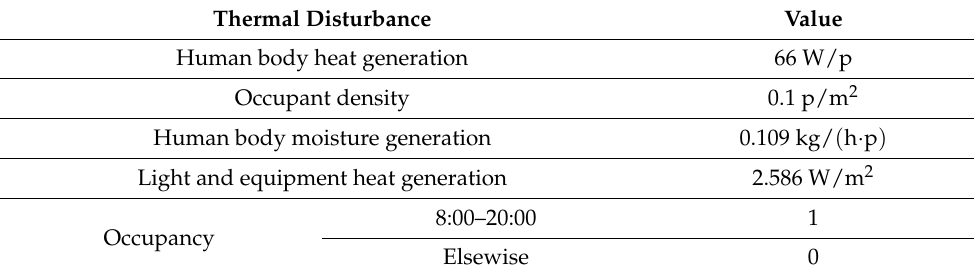
Table 6. Thermal disturbances.